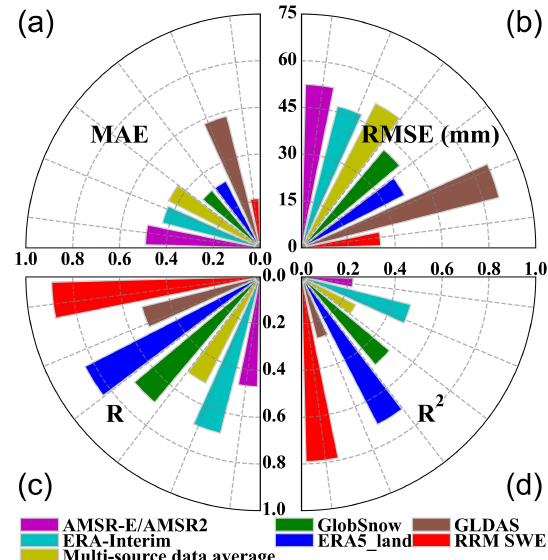
Figure 3. Accuracy comparison of various SWE products. Sector (a) represents the MAE, sector (b) represents the RMSE, sector (c) represents R , and sector (d) represents R 2 . The sector axis repre- sents the size of the error, and the color represents different SWE